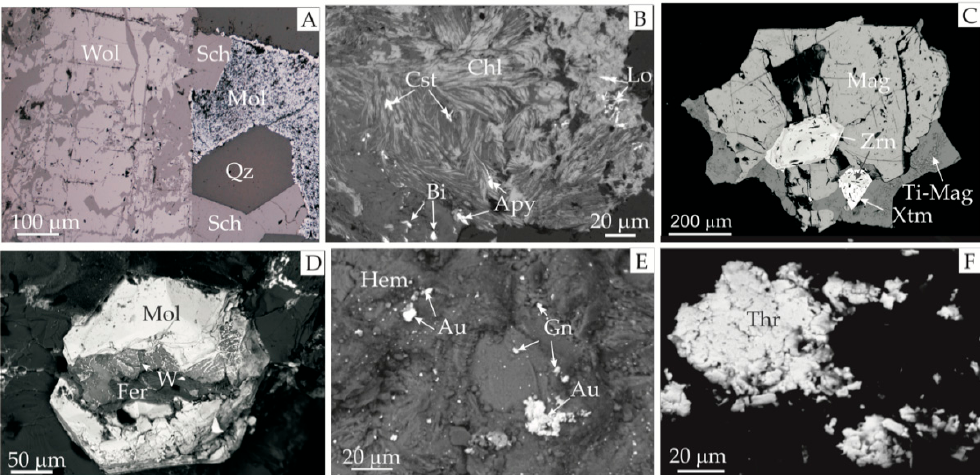
Figure 2. Photomicrographs of ore mineralization from the Szklarska Por ę ba Huta (A–C) and Michałowice quarries (D–F). ( A ) Replacement of wolframite (Wol, hübnerite) by scheelite (Sch) and molybdenite (Mol) by Mo-ochres forming aggregates up to 5 mm in diameter in a quartz (Qz) veinlet. Reflected light; ( B ) finely crystalline cassiterite (Cst) in association with chlorite minerals (Chl), native bismuth (Bi), arsenopyrite (Apy) and löllingite (Lo). BSEI (Backscattered Electron Image); ( C ) titanium-bearing magnetite (Ti-Mag) and magnetite (Mag) in association with zircon (Zrn) and xenotime (Xtm). BSEI; ( D ) Molybdenite (Mol) hexagonal tablets with ferberite (Fer) and secondary tungsten minerals (W), BSEI; ( E ) Native gold grains (Au) in paragenetic association with hematite (Hem) and galena (Gn). BSEI; ( F ) Thorite (Thr) in the form of fine crystalline aggregates associated with hematite. BSEI.